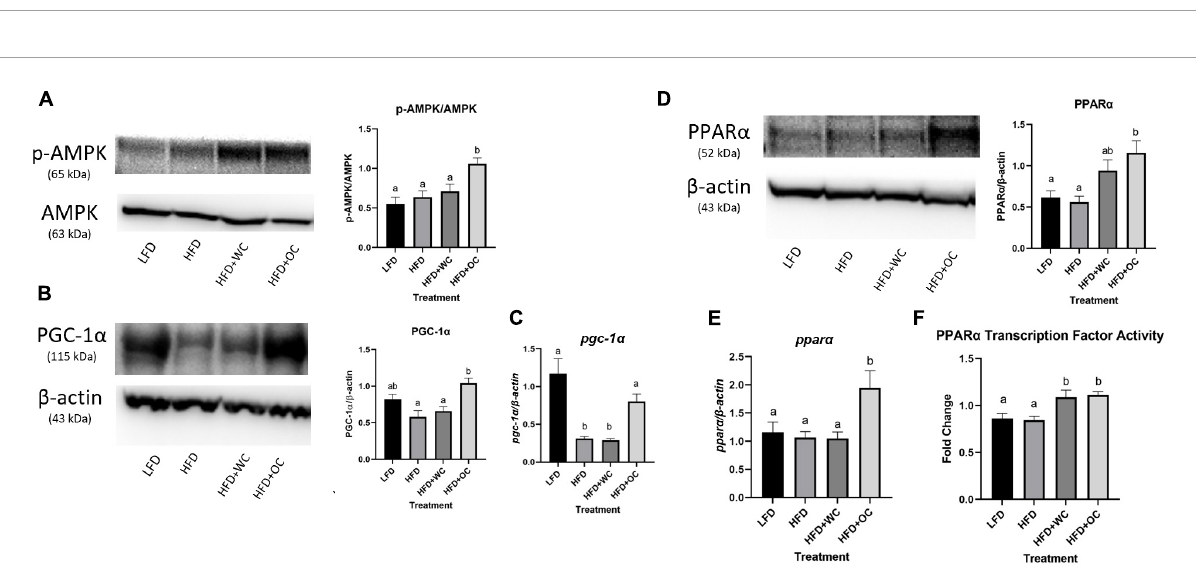
FIGURE6 Carotenoids in HFD + OC diet enhance regulators of hepatic lipid metabolism. (A) Western blot of phosphorylated AMPK (p-AMPK) and total AMPK protein expression, performed with 4–12% Bis-Tris gel; statistical analysis of p-AMPK/AMPK ratio. (B) Western blot of PGC-1 α protein expression, performed with 3–8% tris-acetate gel. (C) Changes in mRNA levels in hepatic pgc-1 α . (D) Western blot of PPAR α protein expression, performed with 4–12% Bis-Tris gel. (E) Changes in mRNA levels in hepatic ppar α . For both western blot and qPCR, LFD: n = 11; HFD, HFD + WC, HFD + OC: n = 12. (F) Graphical changes in nuclear PPAR α transcription factor activity. LFD, HFD, HFD + WC, HFD + OC: n = 10. Values are means ± SEM. The fold change of mRNA, protein, and PPAR α transcription factor activity were analyzed by one-way ANOVA with post hoc Tukey HSD. Letter differences indicate statistical significance ( p <